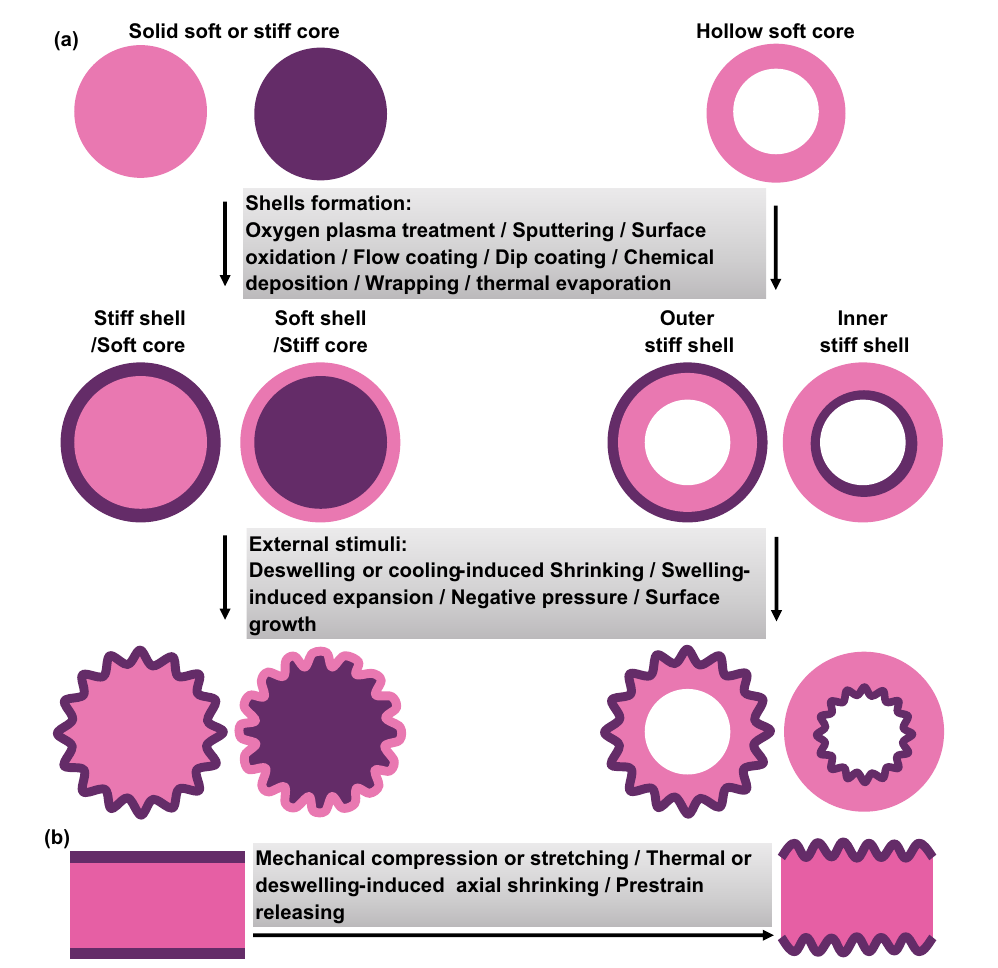
Fig. 4 Schematic illustration of various types of core–shell systems for the fabrication of wrinkling patterning on curved substrates. a Solid cores with stiff or soft shells and hollow substrates with outer or inner stiff shells. b Approaches used to induce axial deformation for ring-pat- terning on core–shell